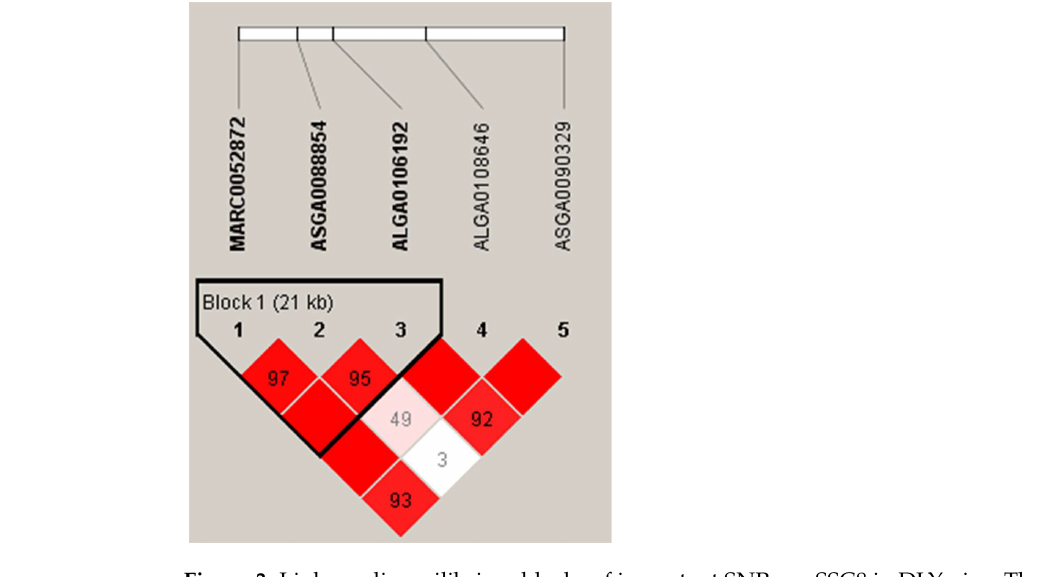
Figure 3. Linkage disequilibrium blocks of important SNPs on SSC8 in DLY pigs. The value in the box is the degree of linkage disequilibrium between SNPs ( r 2 ). box is the degree of linkage disequilibrium between SNPs ( r 2 ).